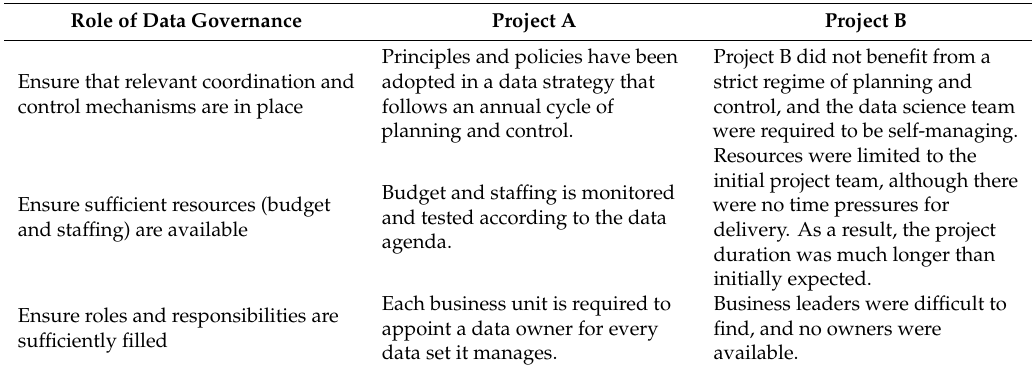
Table 5. Comparison of the cases with regards to the role of data governance in coordinating and controlling the organizational conditions of data